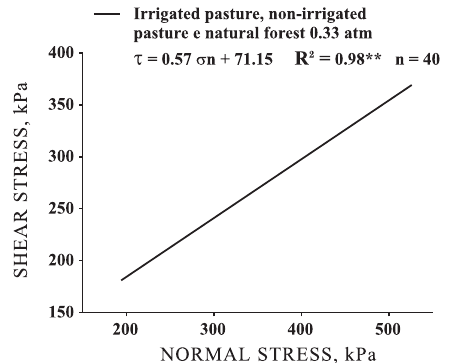
Figure 5. Rupture lines of an LVAd submitted to different management, with samples equilibrated at a water tension of 33 kPa. (Unification of curves of Figure 4). Table 6. Results of the shear tests direct from soil samples exposed to a water tension of 33 kPa